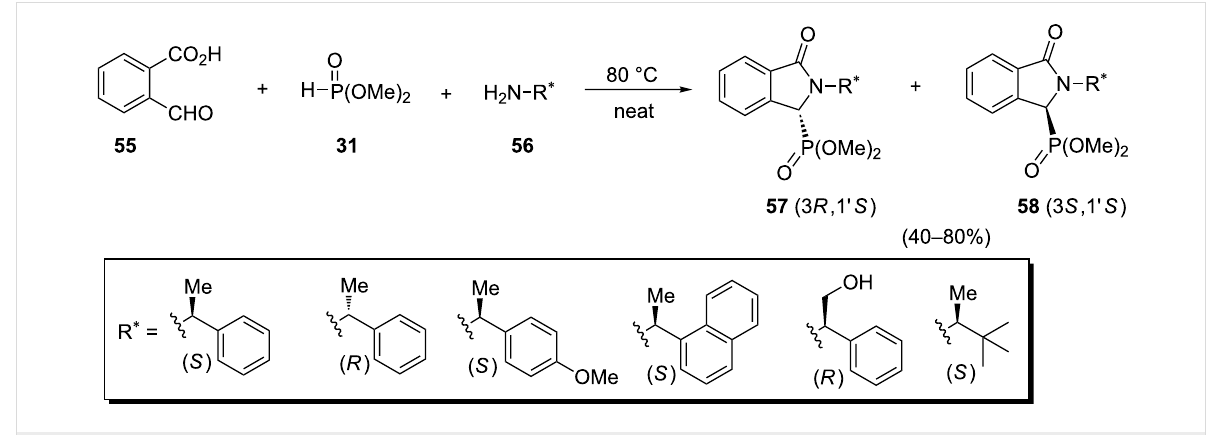
Scheme 14: A modified diastereoselective Kabachnik–Fields reaction for the synthesis of isoindolin-1-one-3-phosphonates.